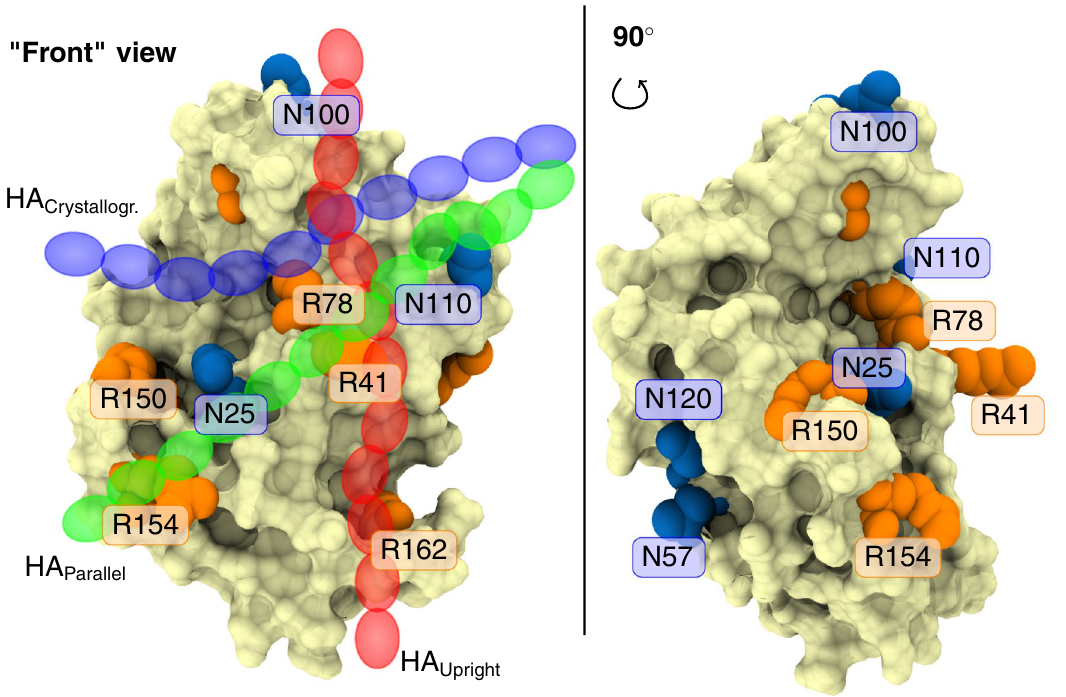
Figure 1. Human CD44-HABD (pale surface) with N-glycosylation sites (blue) and key HA binding arginines (orange) highlighted. Left panel also shows a schematic representation of HA in each binding mode (transparent blue, green, and red